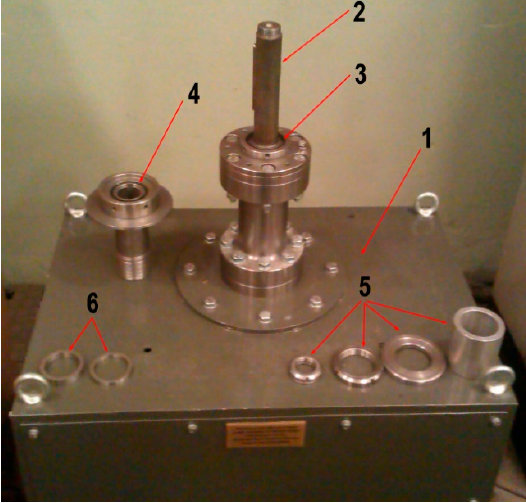
Figure 4. The design of the tribotester: 1—test stand body with a motor; 2—driving shaft; 3—upper holder of the sample; 4—bottom holder of the sample; 5—fixing components; 6—steel ring samples.